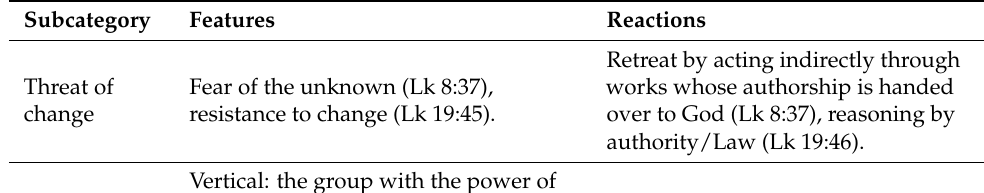
Table 5. Features of power